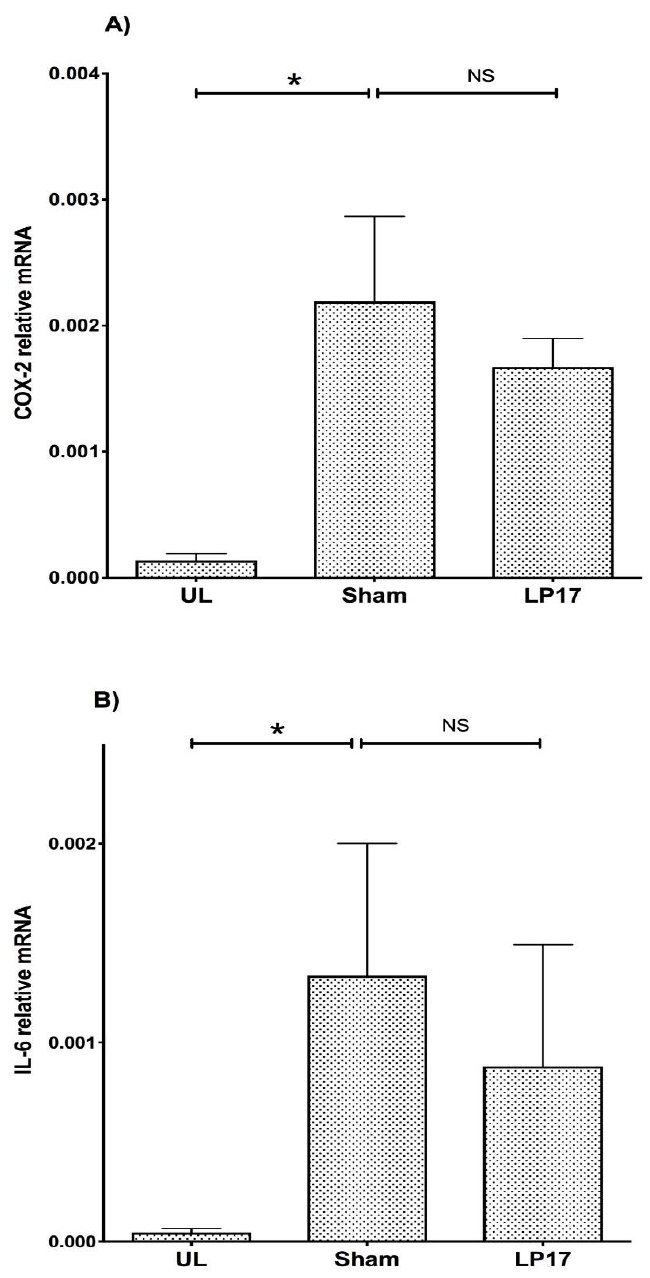
Figure 6. LP17 does not affect COX-2 and IL-6 levels. Gingival tissue samples were dissected at day 5 from mice used in Figure 2 and were processed for gene expression of COX-2 (A) and IL-6 (B) by qPCR. The expression of the indicated molecules was determined in unligated (UL) control gingiva and in ligated gingival tissues treated with 5 µ g synthetic TREM-1 inhibitor (LP17) or PBS sham. The gene expression levels were detected by TaqMan real-time qPCR and calibrated against the expression of the housekeeping gene β -actin . Results are means ± SEM ( n = 4 mice / group). NS: Not significant, p > 0.05.